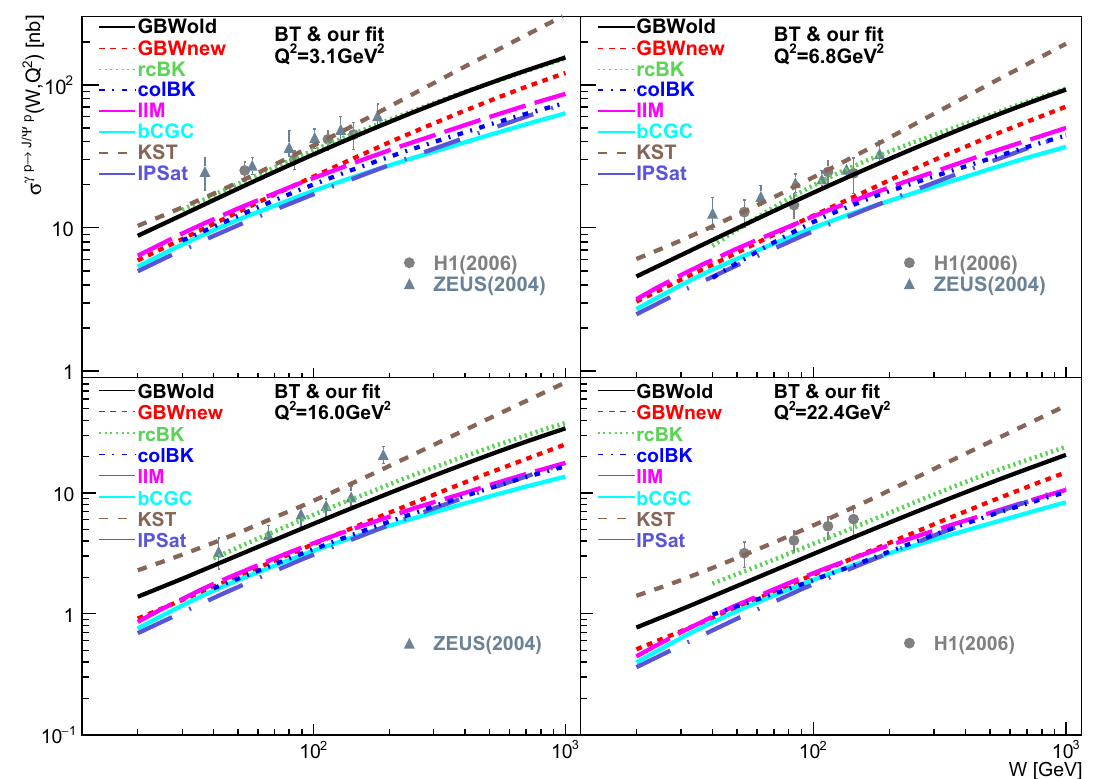
Fig. 16 The exclusive J /ψ electroproduction cross section as a func- tion of energy W at several fixed values of Q 2 = 3 . 1 GeV 2 (top left panel), Q 2 = 6 . 8 GeV 2 (top right panel), Q 2 = 16 . 0 GeV 2 (bottom left panel), and Q 2 = 22 . 4 GeV 2 (bottom right panel). The model pre-